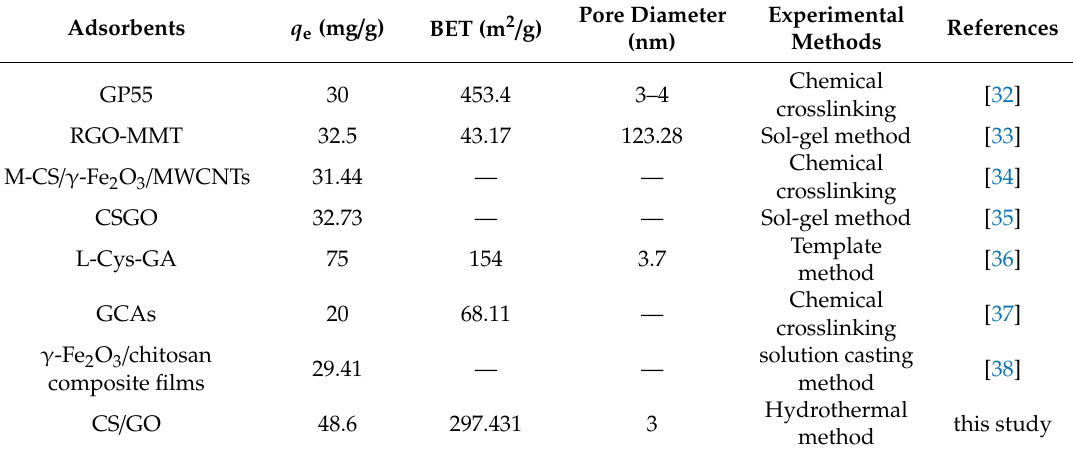
Table 6. Comparison of adsorption of di ff erent adsorbents for MO [32–38].